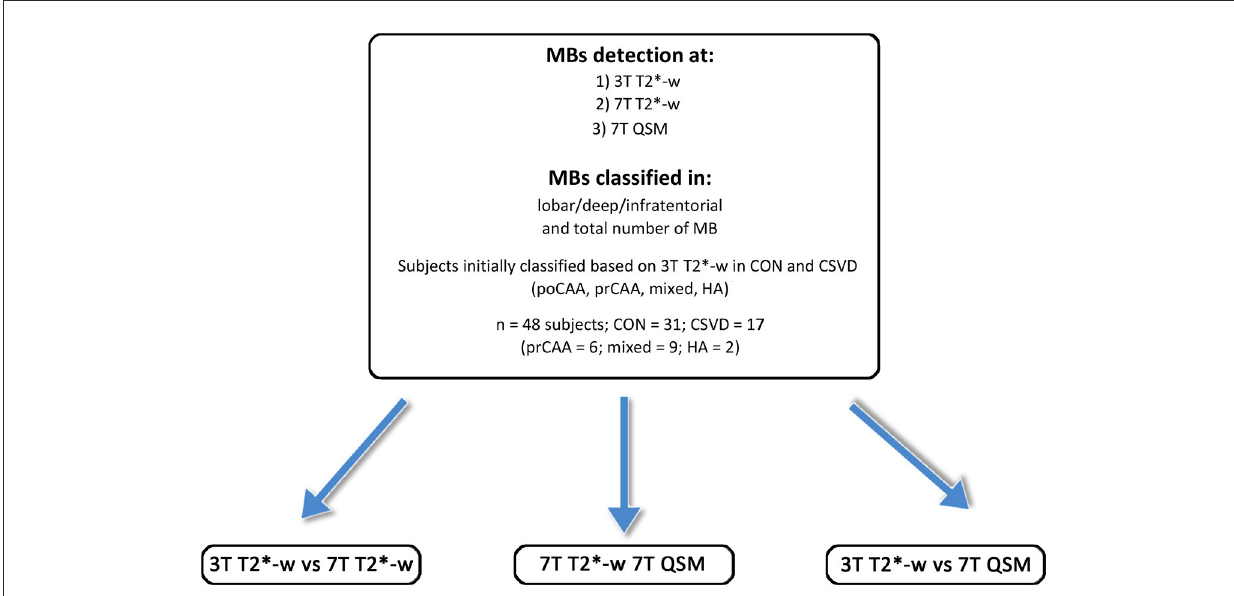
FIGURE2 Overview of the study participants, the subgroups and the MRI scans performed. CAA, cerebral amyloid angiopathy; poCAA, possible CAA; prCAA, probable CAA; CON, controls; HA, hypertensive arteriopathy.